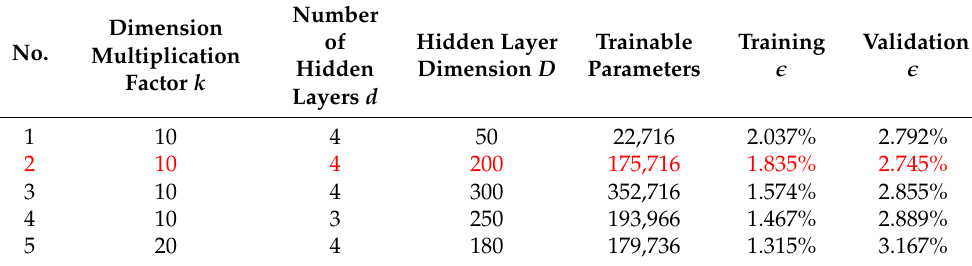
Table 4. Error comparison of different networks in model H 3 tuning tests. The network 2 (in red) is the final